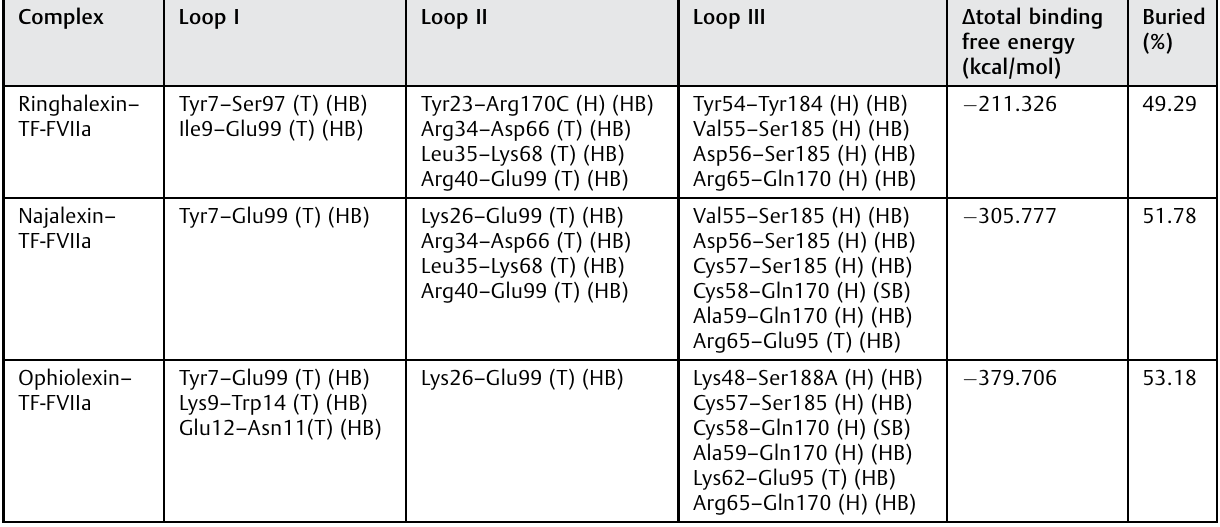
Table 3 Residues of ringhalexin, najalexin, ophiolexin, and TF-FVIIa involved in interactions based on protein – protein docking studies